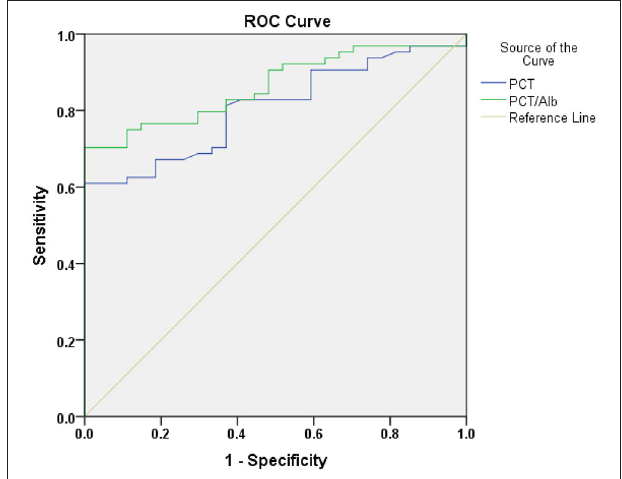
FIGURE 2 | The predictive value of PCT and PCT/Alb in the poor prognosis of sepsis-induced AKI patients.